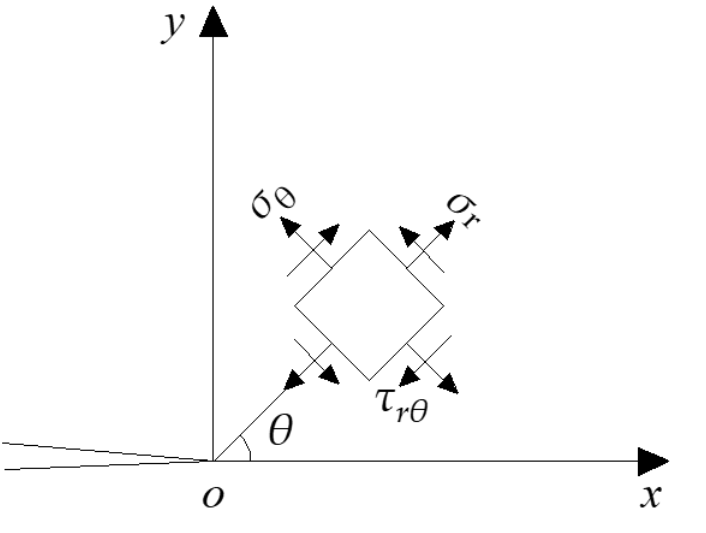
Figure 13. Polar components of crack tip stress.